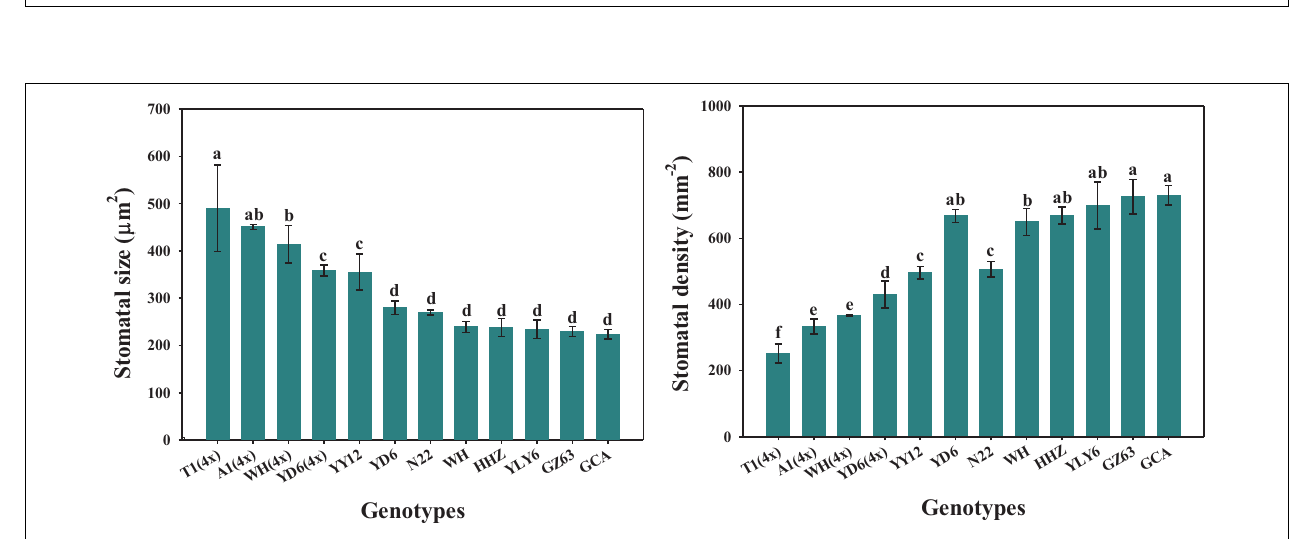
FIGURE 6 | Variations of stomatal size and density across twelve rice genotypes. Different letters indicate statistically significant differences ( P < 0.05) among twelve rice genotypes.